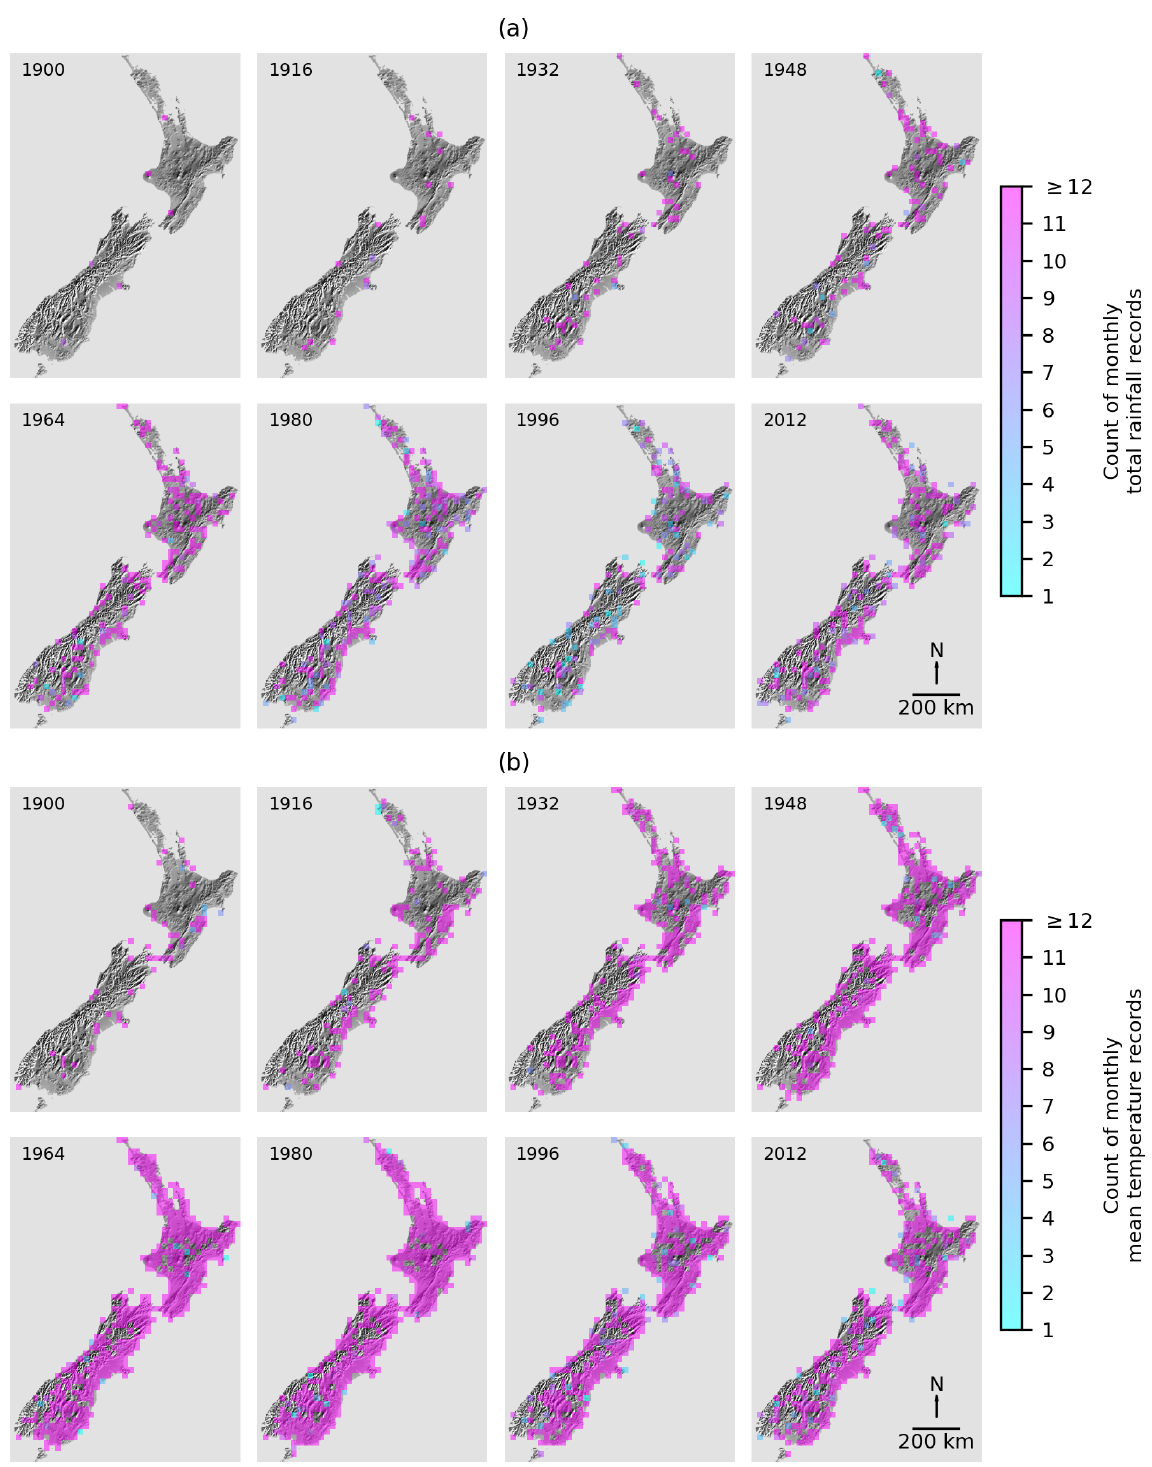
Figure 2. A time series of the total number of monthly weather records for each year within 25km × 25km grid cells for (a) total rainfall and (b) mean air temperature (which are similar to mean daily maximum air temperature and mean daily minimum air temperature). Cells with ≥ 12 records will usually mean at least one weather station is present with records for all 12 months of the year, but in some instances many weather stations may be present, resulting in tens or hundreds of records per grid